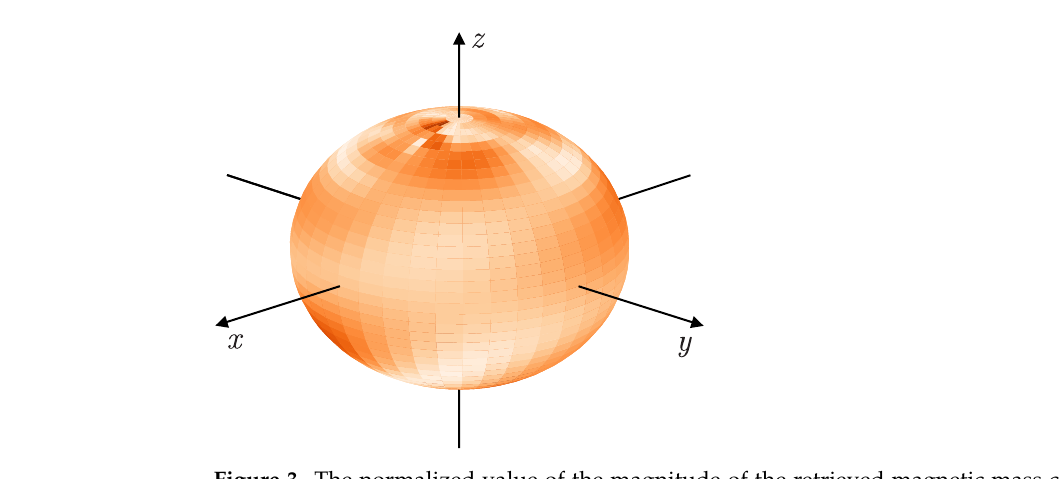
Figure 3. The normalized value of the magnitude of the retrieved magnetic mass carrier density M ( ρ cos ϕ sin θ , ρ sin ϕ sin θ , ρ cos θ ) . The calculations were carried out for data localized in the spher- ical layer S 2 . Regularization parameter: α = 10 − 14 .